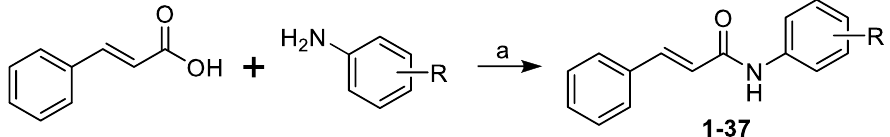
Scheme 1. Synthesis of (2 E )- N -aryl-3-phenylprop-2-enamides 1 – 37 . Reagents and conditions: (a) PCl 3 ,